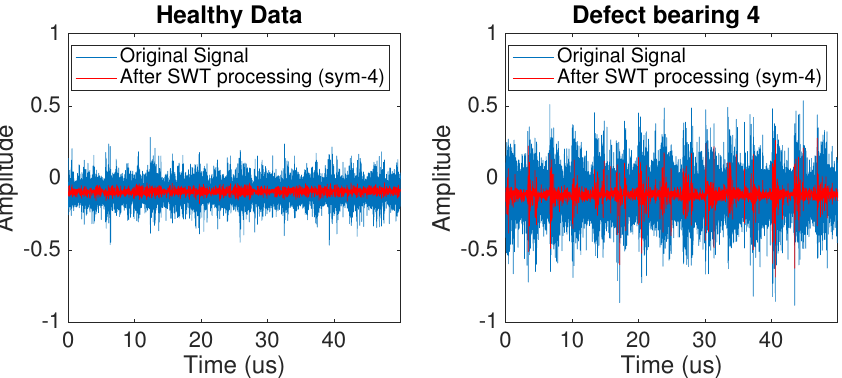
Figure 3. Before and after de–noising using Stationary Wavelet